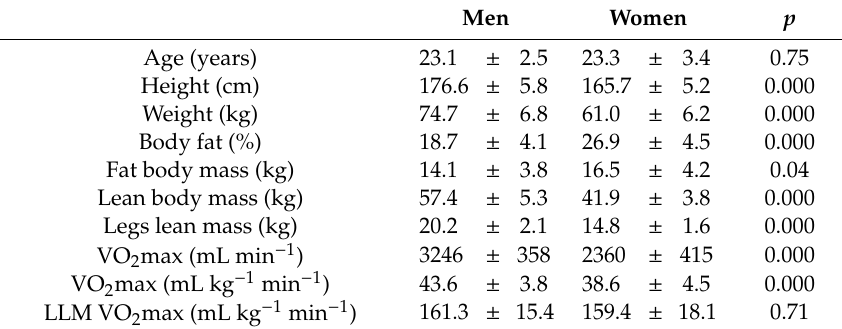
Table 1. Physical characteristics, body composition and VO 2